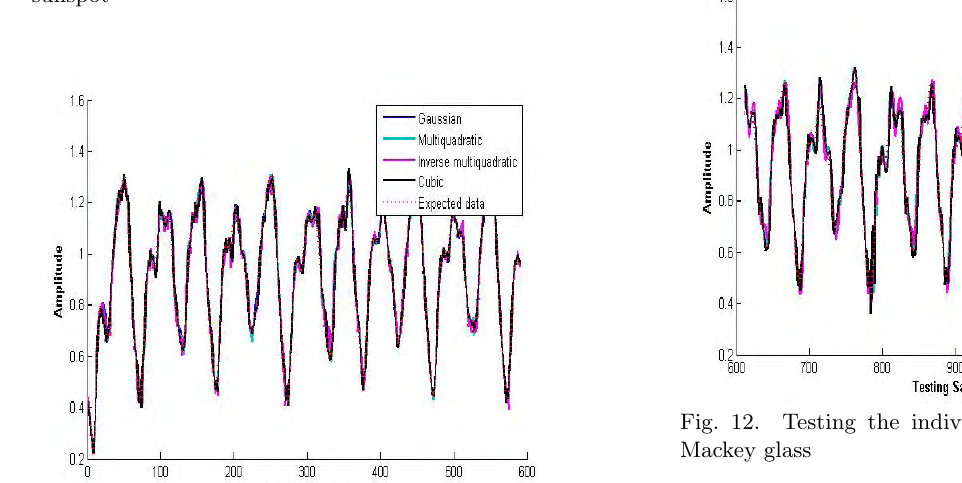
Fig. 9. Training the individual NARX-RBFNNs - sunspot